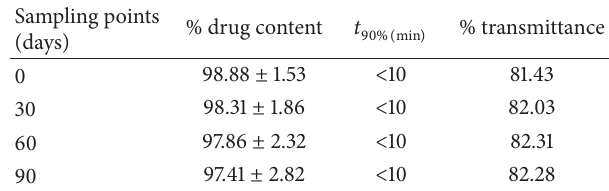
Table 6: Evaluation data of optimized SNEDDS formulation sub- jected to stability studies at 40 ± 2 ∘ C/75 ± 5%